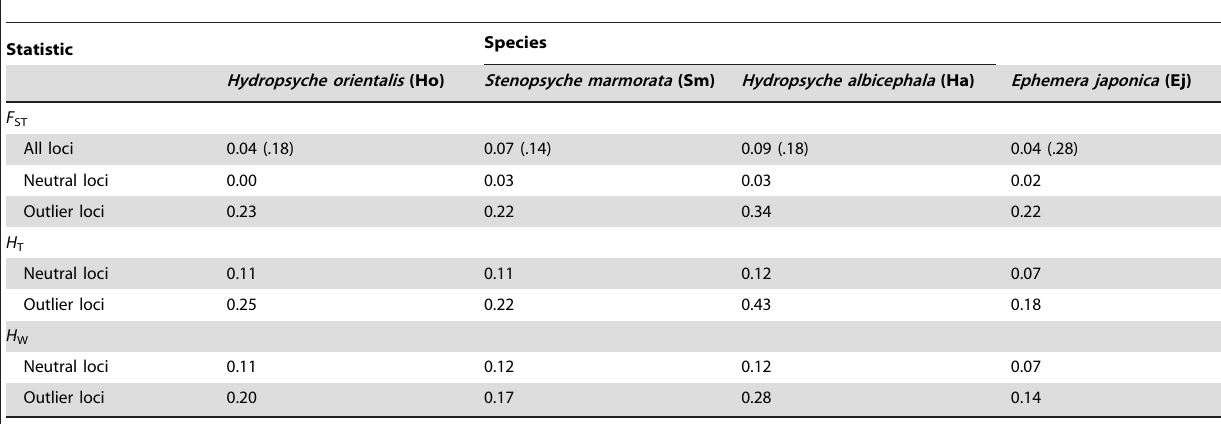
Table 2. Summary of genetic structure and diversity measured using all loci, neutral loci, and outlier loci.